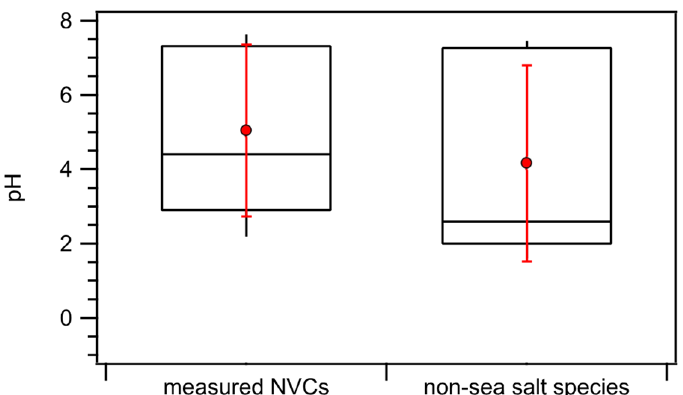
Figure 5. Box plots depicting the median pH values calculated by ISORROPIA-II for internally mixed aerosols vs. the aerosol mode containing only non-sea salt species. Standard box-and-whisker plots are shown, with the 90th and 10th percentile data indicated by black error bars. The top and bottom of the box are the interquartile ranges (75th and 25th percentile) centered around the median value (50th percentile). The red symbols denote the means, and the red error bars are 1 standard deviation.